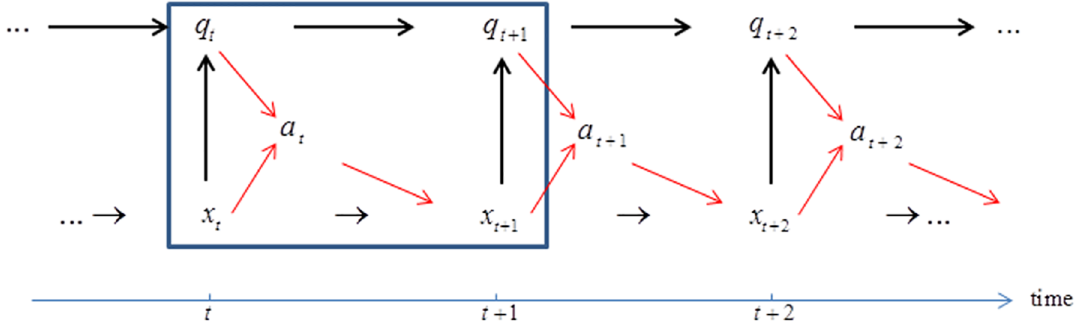
Fig 2. Scenario 1: Annual decision making and annual monitoring. Action a t is selectedbased on system state x t and model state q t . Realizedsystem state x t +1 is identifiedthrough monitoring in year t +1. Model state q t is updatedto q t +1 with by Bayes’ theorem. This sequence,with actions based on current system and model state, is repeatedover the remainderof the time